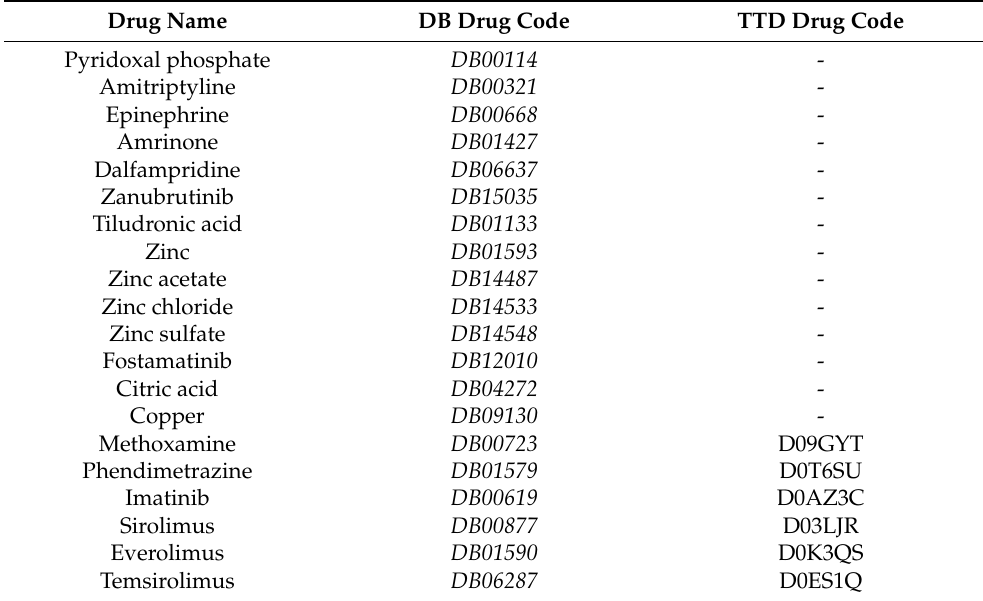
Table 2. Common approved drugs between the siRNAs targets and interactors from the “Drug Bank” (DB) database, and among both “Drug Bank” (DB) and “Therapeutic Target Database”